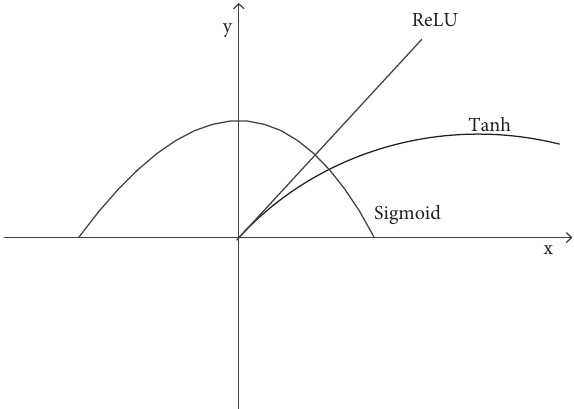
Figure 6: Image comparison of the deep learning activation function.